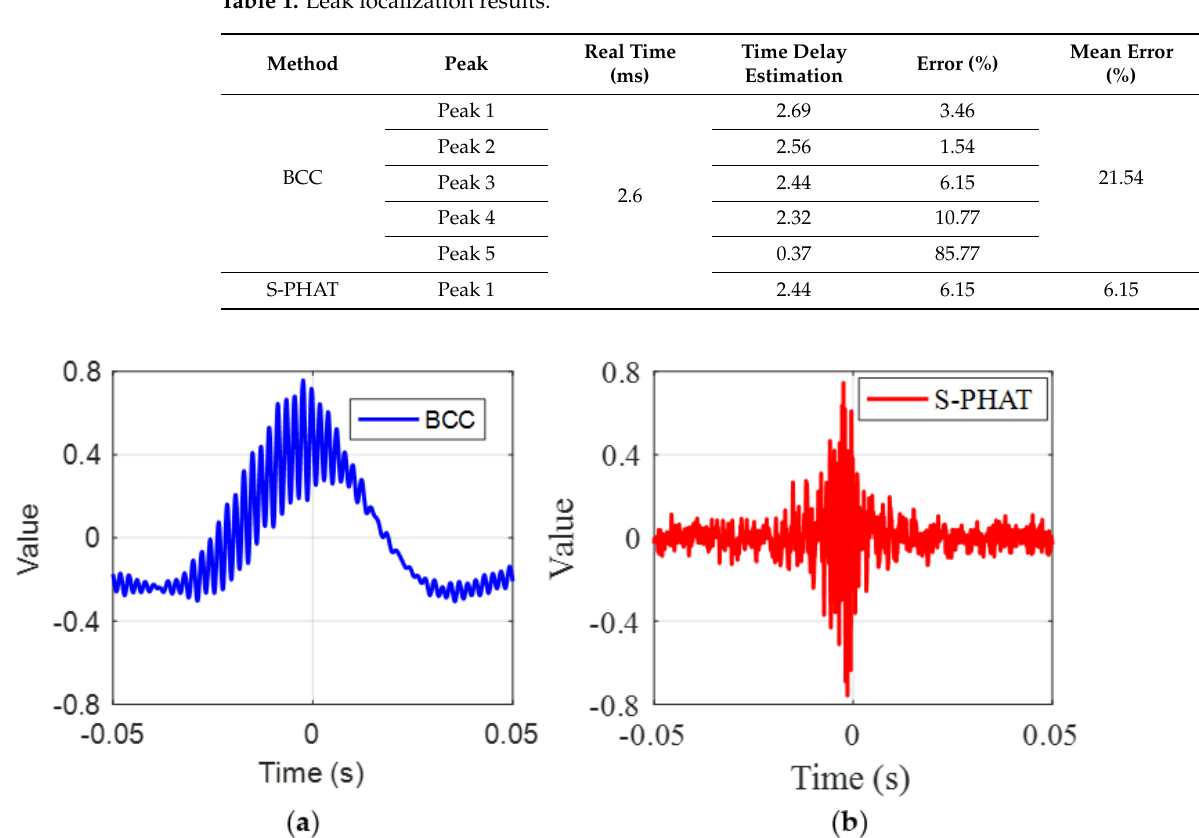
Figure 14. Local results marked by a red box in Figure 13: ( a ) the BCC method; and ( b ) the secondary PHAT cross-correlation method.